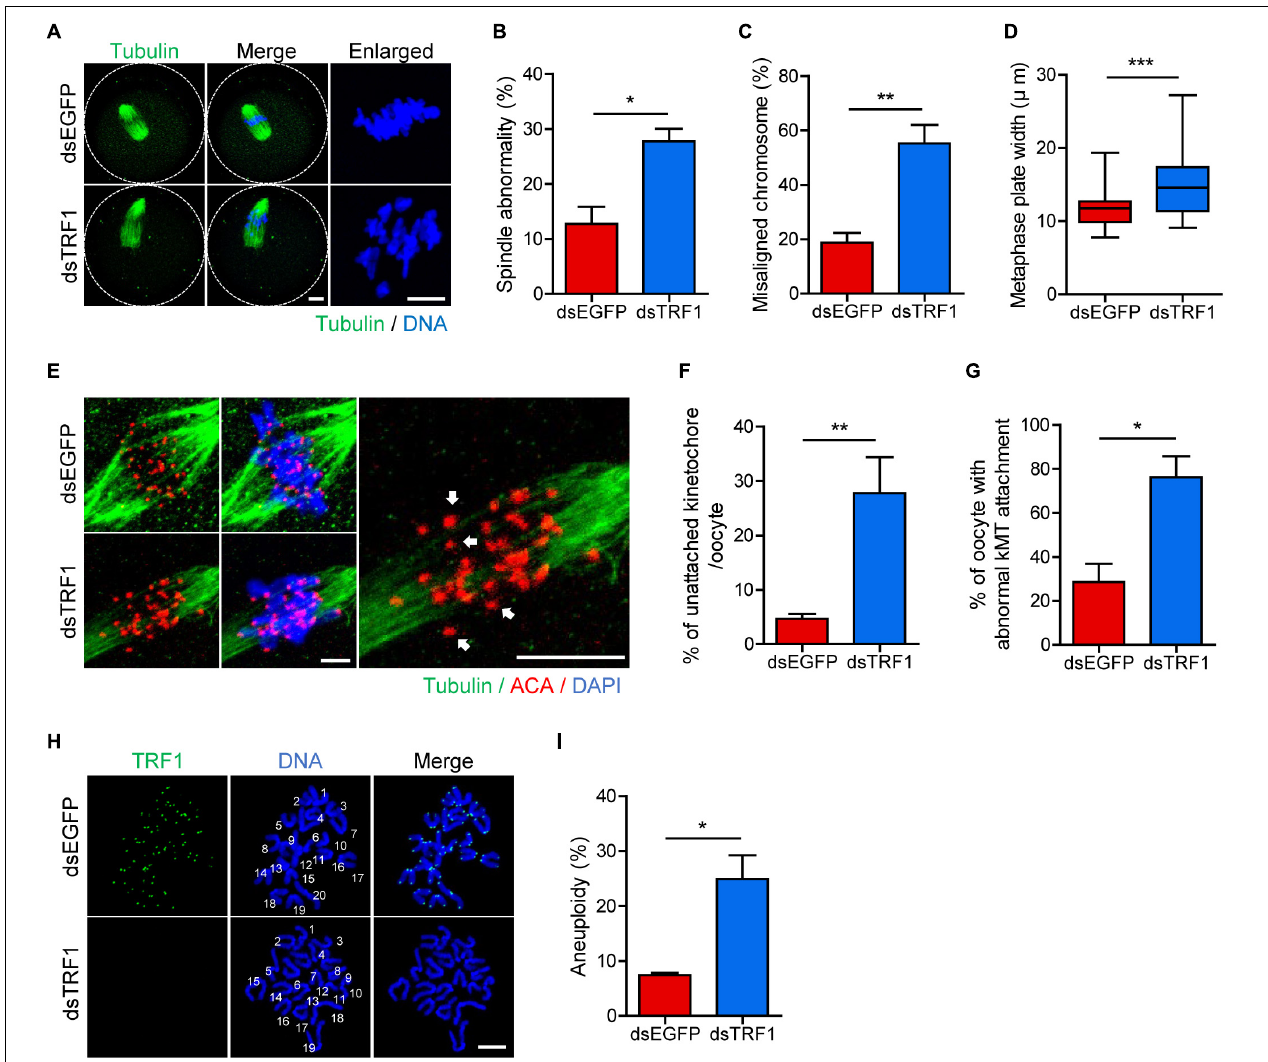
FIGURE 2 | TRF1 depletion impairs kMT attachment and increases the rate of aneuploidy. Oocytes injected with dsEGFP or dsTRF1 were cultured in medium containing IBMX for 24 h and then transferred to IBMX-free medium for 8 h. (A–D) Oocytes at the MI stage were fixed and stained with anti- α -tubulin antibody and DAPI (scale bar, 10 µ m). Spindle abnormality, chromosome misalignment, and metaphase plate width were quantified and are shown in representative images. Data are presented as mean ± SEM from three independent experiments. (E–G) After cold treatment, oocytes were fixed and stained with anti-centromere antibody (ACA), anti- α -tubulin antibody, and DAPI to visualize kinetochore, spindle, and DNA, respectively. The percentages of unattached kinetochores per oocyte and oocytes with abnormal kMT attachment were quantified, also shown in representative images (scale bar, 10 µ m). Data are presented as mean ± SEM from three independent experiments. (H,I) Chromosome spreading of TRF1-depleted MII oocytes. Kinetochores and DNA were stained with ACA and DAPI, respectively (scale bar, 20 µ m). The incidence of aneuploidy was quantified. Data are presented as mean ± SEM. * p < 0.05, ** p < 0.01, *** p <